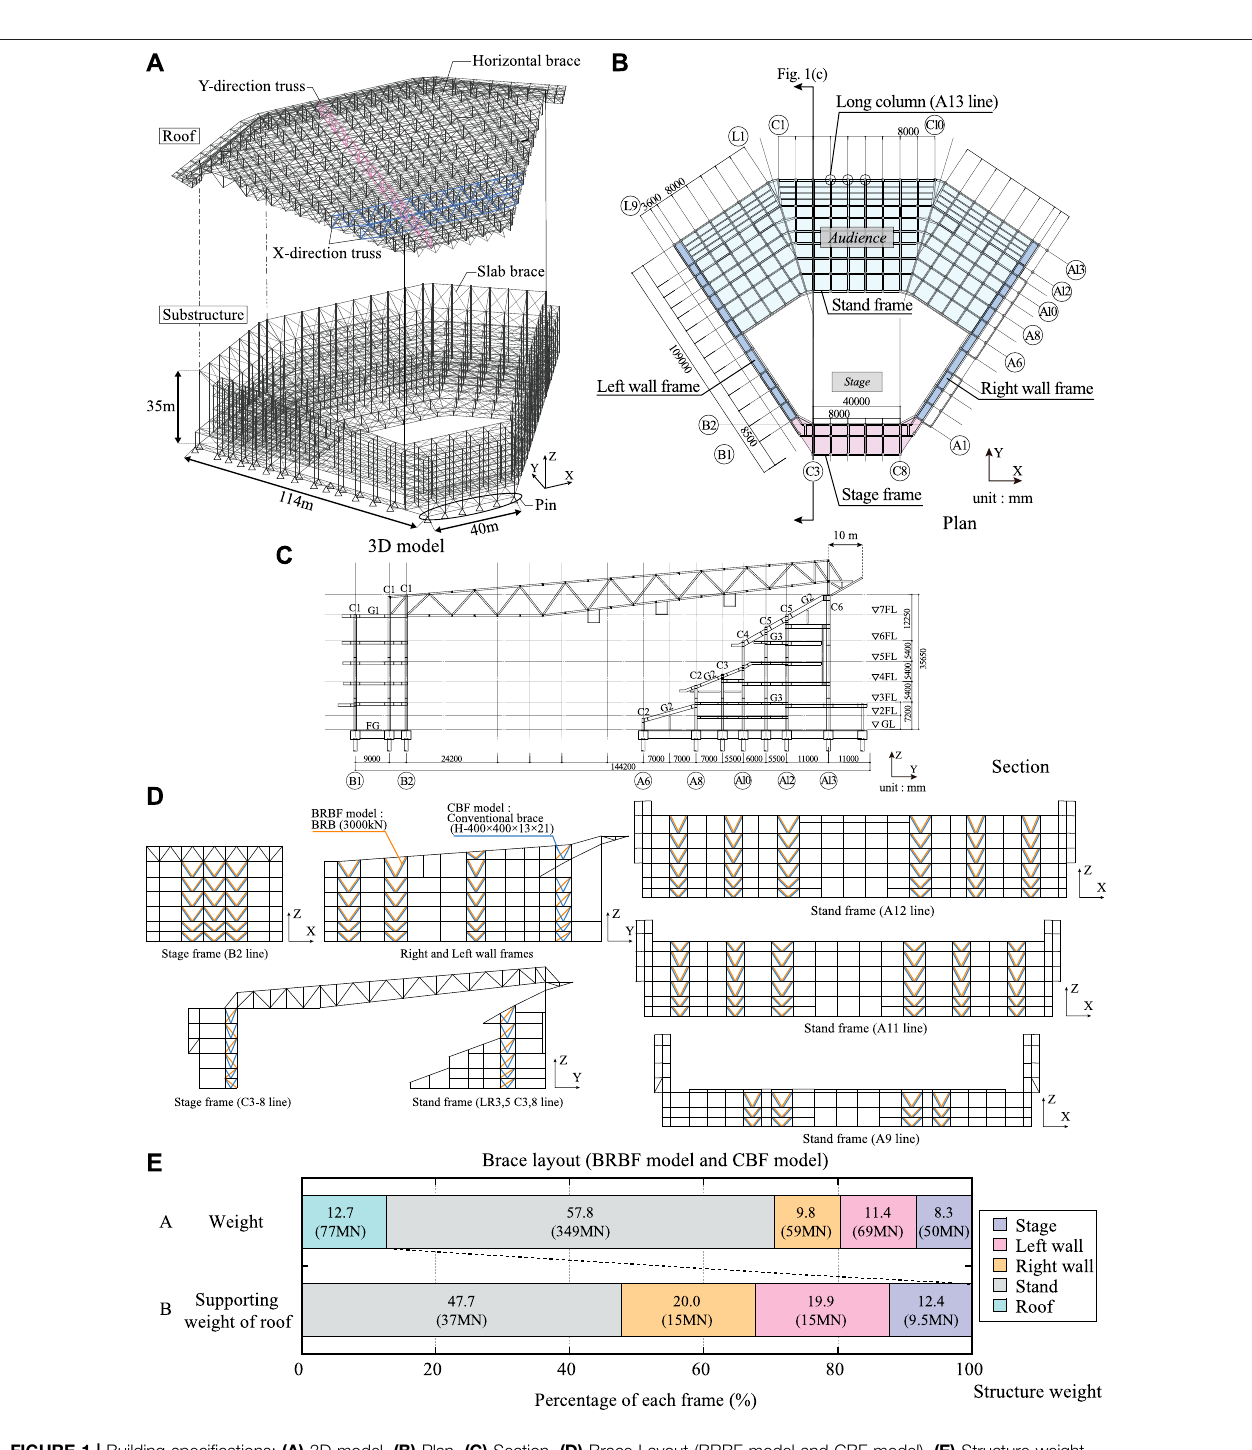
FIGURE 1 | Building speci fi cations: (A) 3D model, (B) Plan, (C) Section, (D) Brace Layout (BRBF model and CBF model), (E) Structure weight.